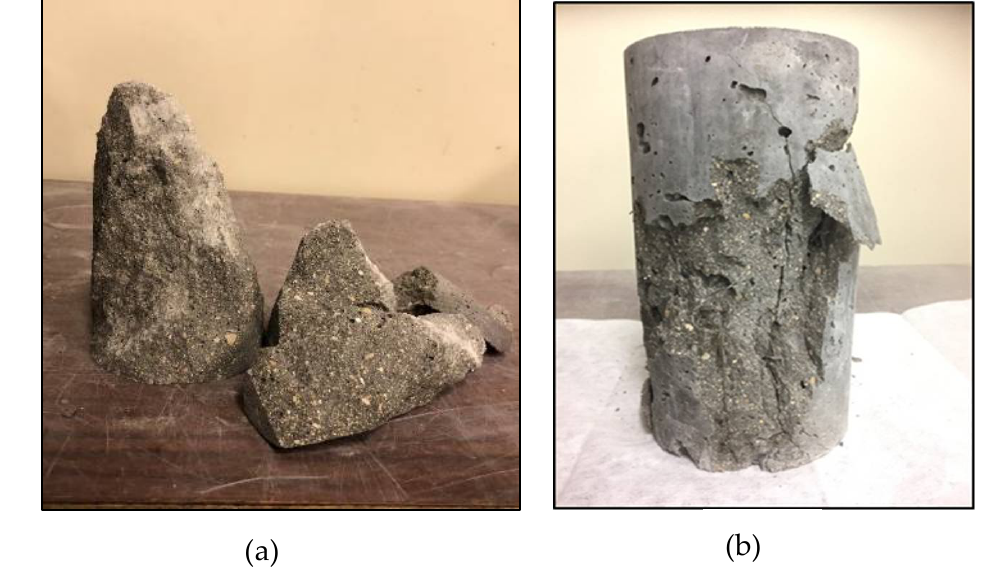
Figure 3. Mode of failure of specimens: ( a ) without fibers, and ( b ) with steel fibers.